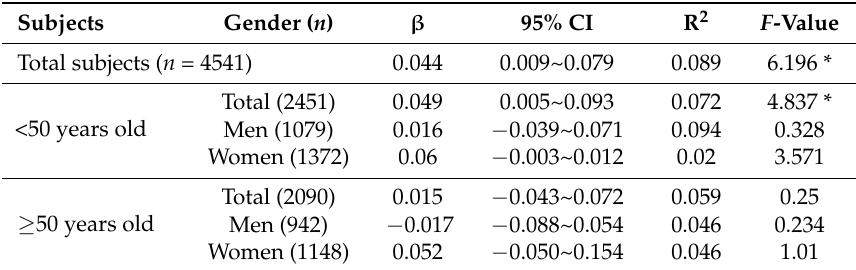
Table 3. Relationship between vitamin D intake and serum 25-hydroxyvitamin D concentration adjusted for confounding factors.